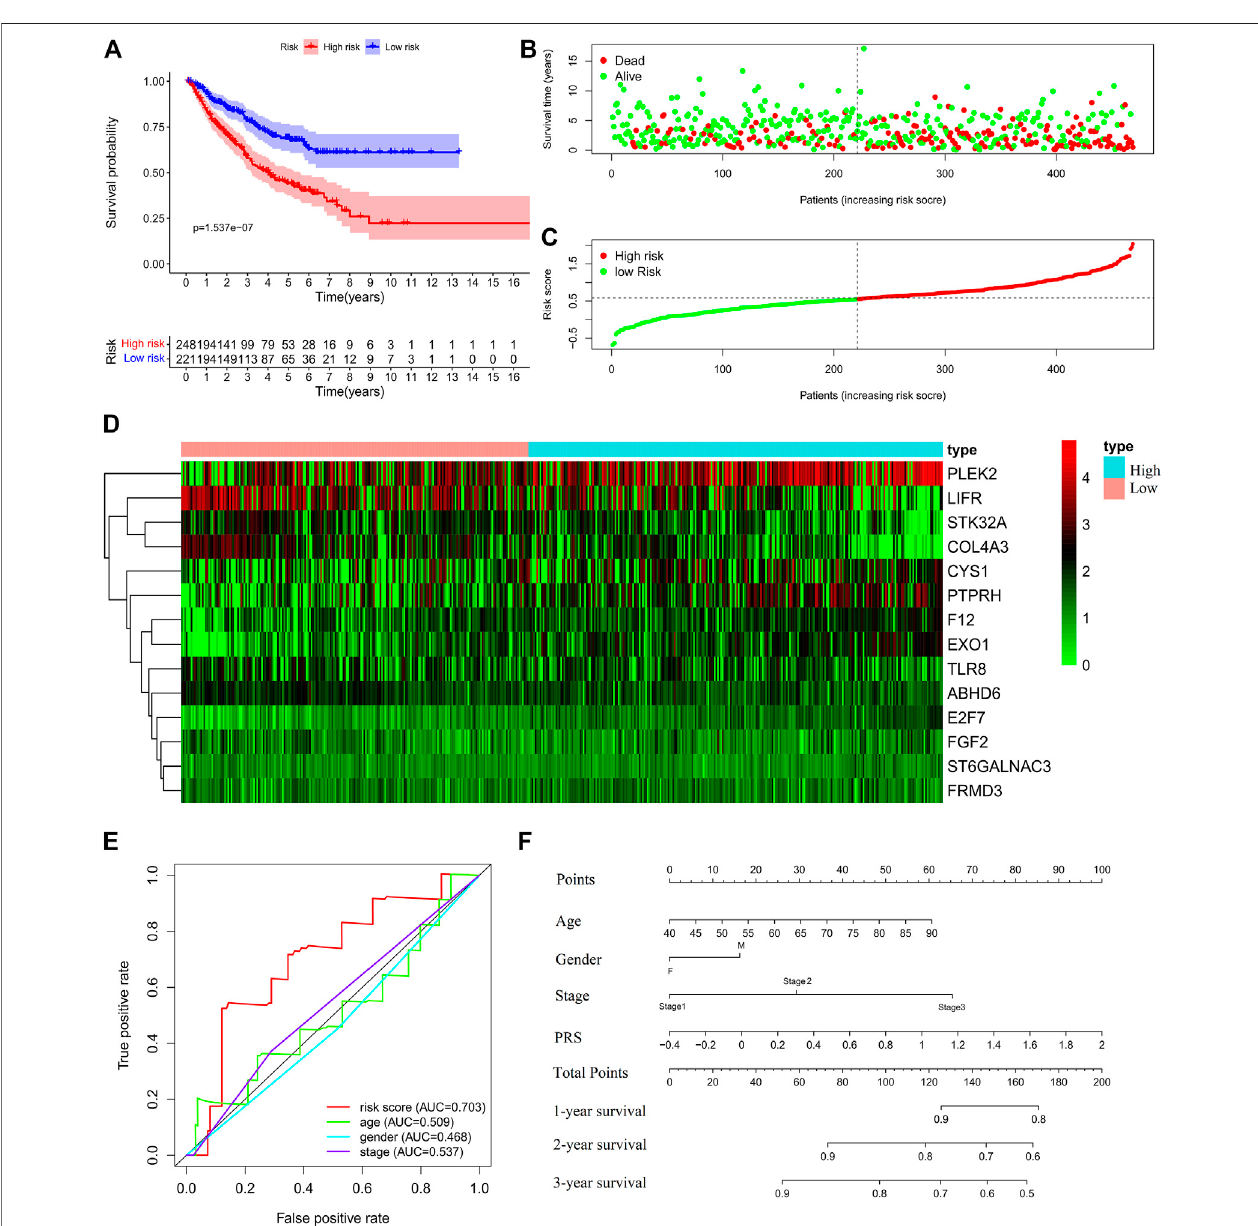
FIGURE 4 | Validation of the prognostic risk score (PRS) model in the test set. (A) Comparisons of overall survival (OS) between the high- and low-risk groups. (B) Distribution of survival time among patients with different outcomes. (C) Distribution of increasing risk scores in high- and low-risk groups. (D) Heatmap of the 14-gene expressionpro fi lesinhigh-andlow-riskgroups. (E) ROCsofmodelswithsex,stage,andPRSasvariablesinthetestsets,respectively. (F) Nomogramtopredictthe1-, 2-, and 3-years survival rates of patients in the test set by using sex, stage, and risk score as variables,